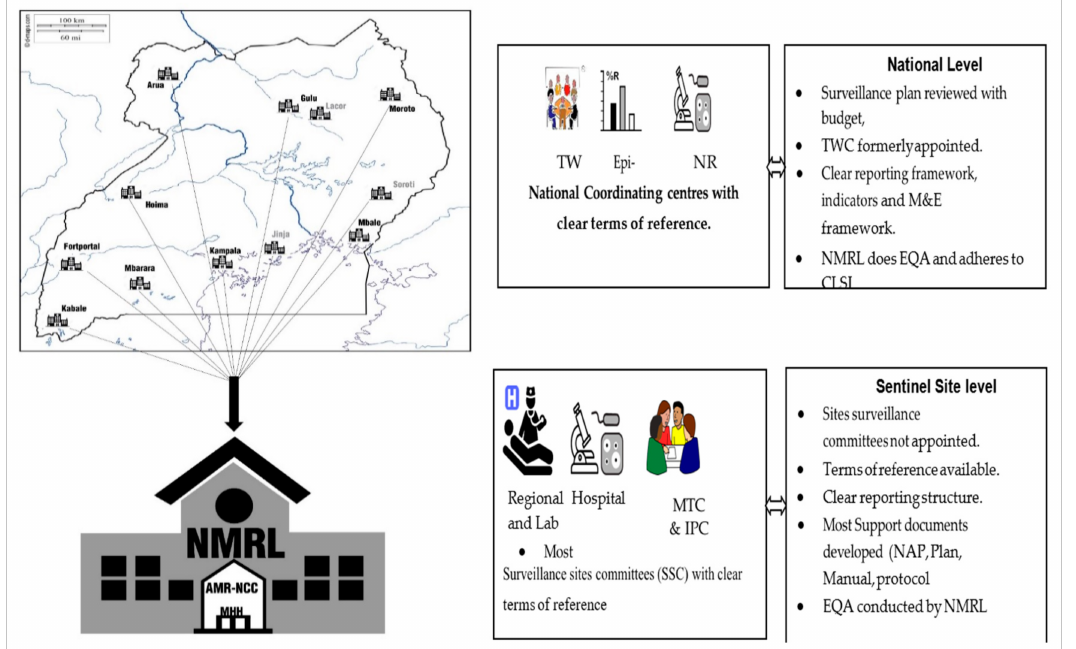
Figure 2. Uganda’s design of AMR Sentinel Surveillance system based on the already-existing Ministry of Health structure of regional referral hospitals and how functional linkages for conducting AMR surveillance from the facility level are extended to the national